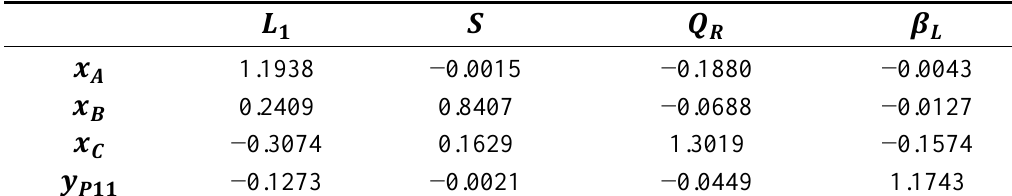
Table 3. Relative Gain array (RGA) for DB stabilization control.